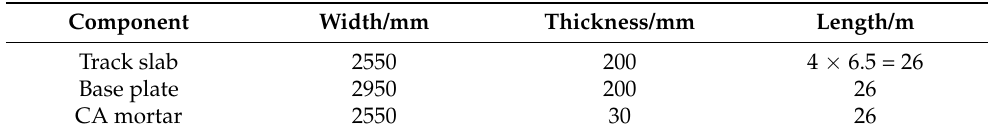
Table 1. Dimensions of each component.